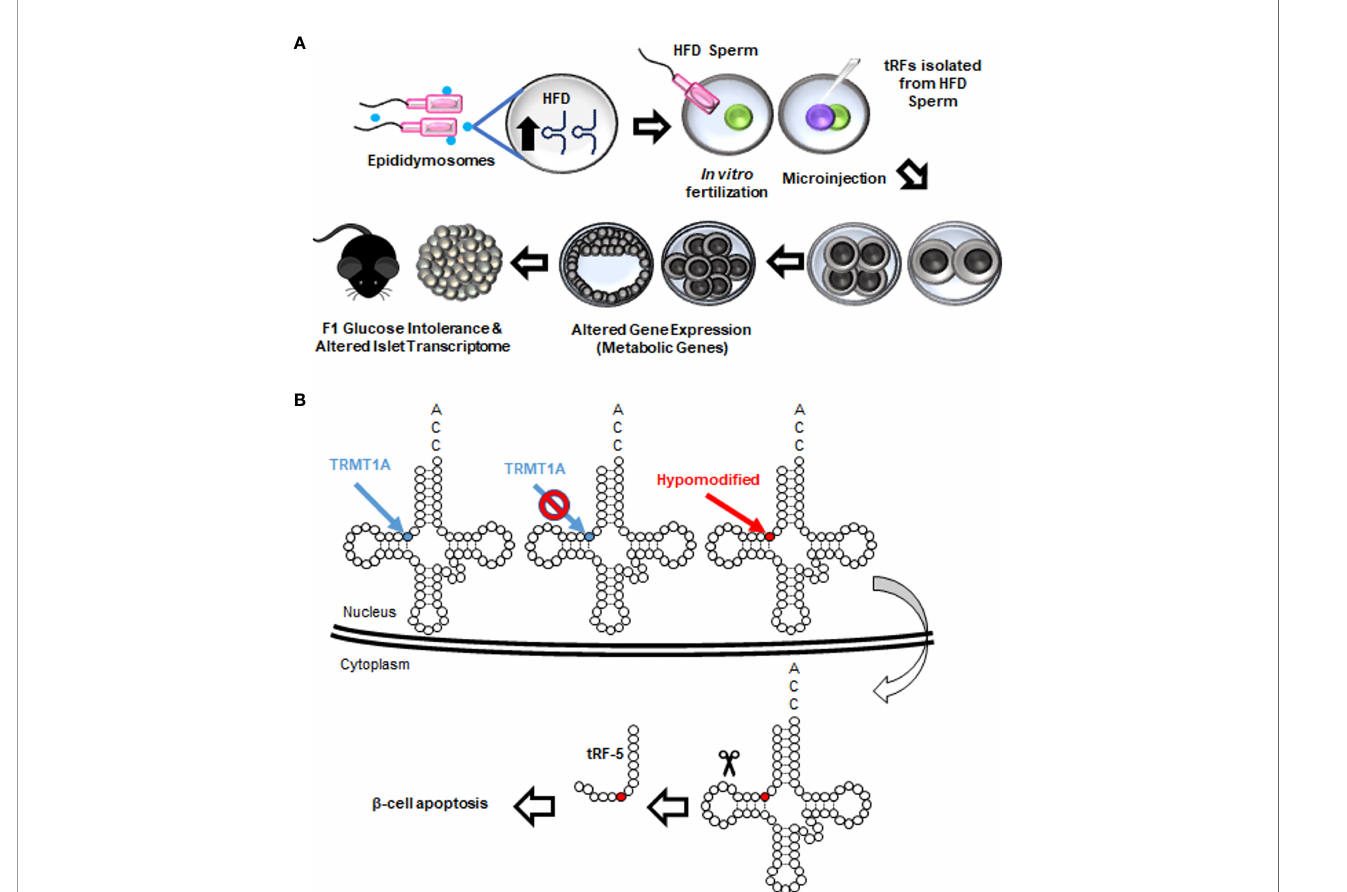
FIGURE 7 | Roles of tRFs in metabolic disorders and b -cell dysfunction. (A) Paternal high fat diet (HFD) increases the abundance of tiRNA-5s that are packaged inside epididymis-derived exosomes (epididymosomes). Epididymosomes fuse with the sperm and transfer these fragments. When normal zygotes are fertilized with HFD sperm or microinjected with tRFs isolated from HFD sperm, expression of metabolic genes in eight-cell and blastocyst-stage embryos is drastically altered. The resulting offspring exhibit abnormal metabolism at adulthood, including glucose intolerance and alterations in pancreatic islet transcriptome. A similar metabolic function of tRFs is observed upon a paternal low protein diet. (B) TRMT10A de fi ciency is associated with hypomethylation of guanosine residues at position 9 of certain tRNAs. Hypomethylated tRNAs are transported to the cytoplasm and fragmented. tRF-5s generated from such fragmentations lead to b -cell